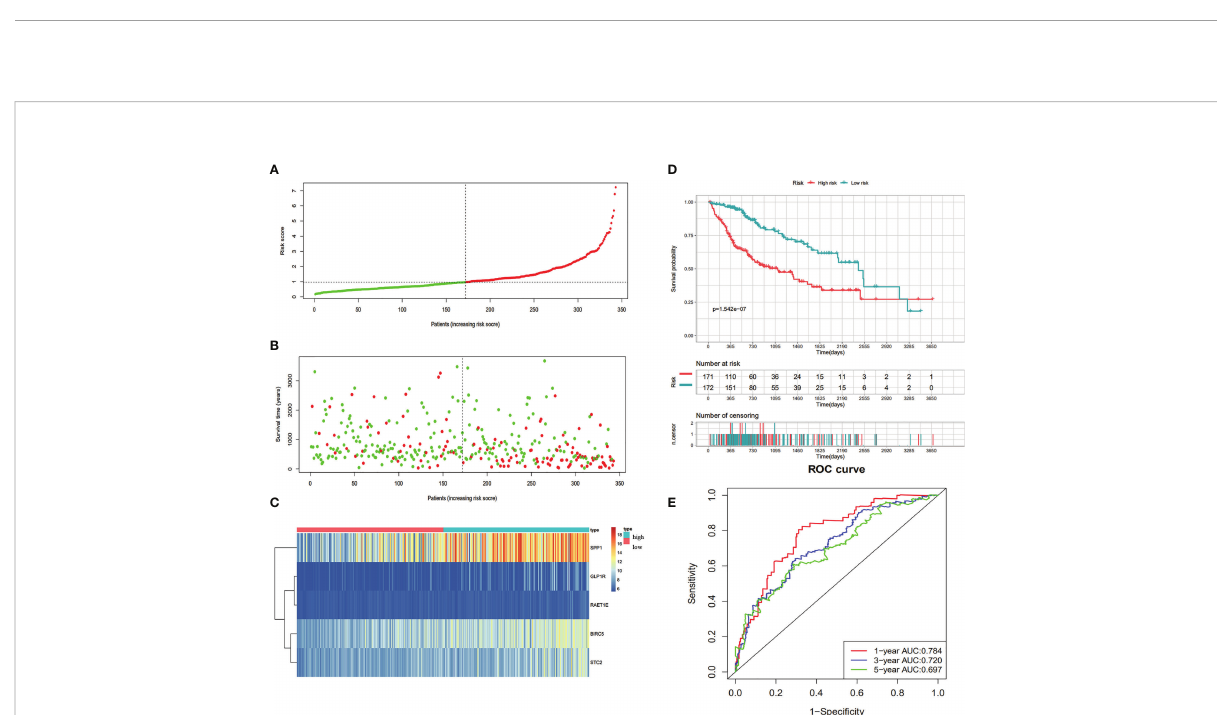
FIGURE 4 Construction of the immune-based prognostic risk signature in the TCGA cohort. (A) The risk score distribution of HCC patients. (B) Survival status and duration of patients. (C) Heatmap of the expression of the immune-related genes. (D) Survival curves for the low risk and high-risk groups. (E) Time-independent receiver operating characteristic (ROC) analysis of risk scores for prediction the OS in the TCGA